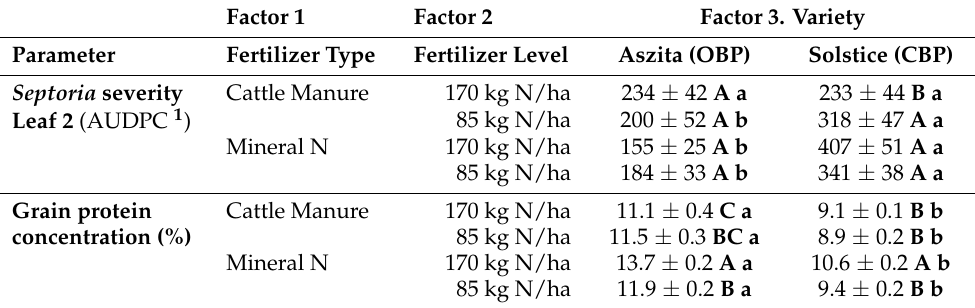
Table 5. Interaction means ± SE 1 for the effects of fertilizer type, fertilizer input level and variety on Septoria severity and grain protein concentrations in two winter wheat ( T. aestivum ) field trials carried out at Nafferton Farm, Northumberland,